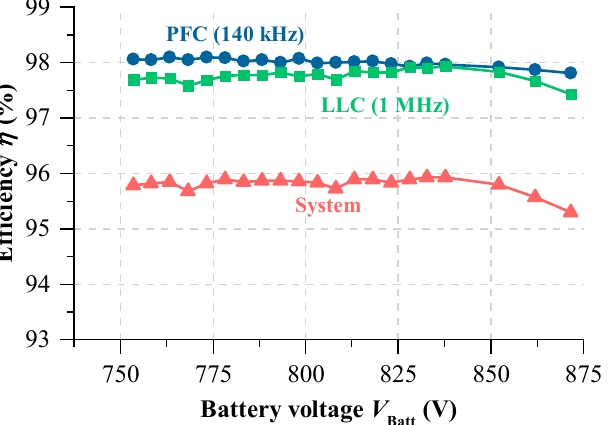
Figure 28. Measured efficiency of the V IENNA PFC, the three-phase LLC resonant converter, and the entire system under full load.